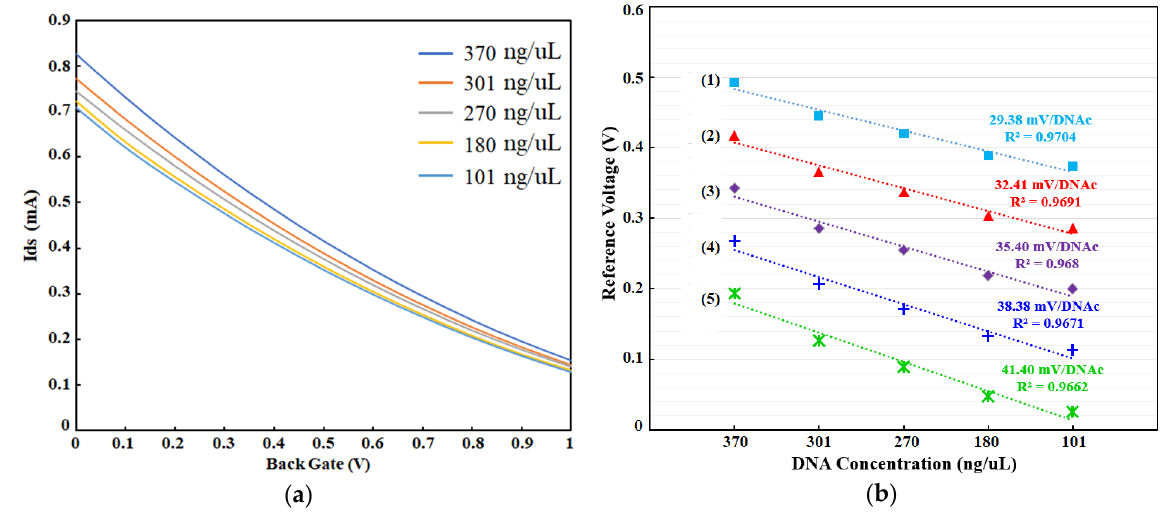
Figure 12. Sensor response to single-strand DNA concentration. ( a ) Ids-Vgs curve for different concentrations of ssDNA (370 ng/uL, 301 ng/uL, 270 ng/uL, 180 ng/uL, 101 ng/uL). ( b ) Voltage sensitivity results of OG-JFET response to ssDNA concentration at different reference currents of (1) 0.45 mA, (2) 0.50 mA, (3) 0.55 mA, (4) 0.60 mA, and (5) 0.65 mA.